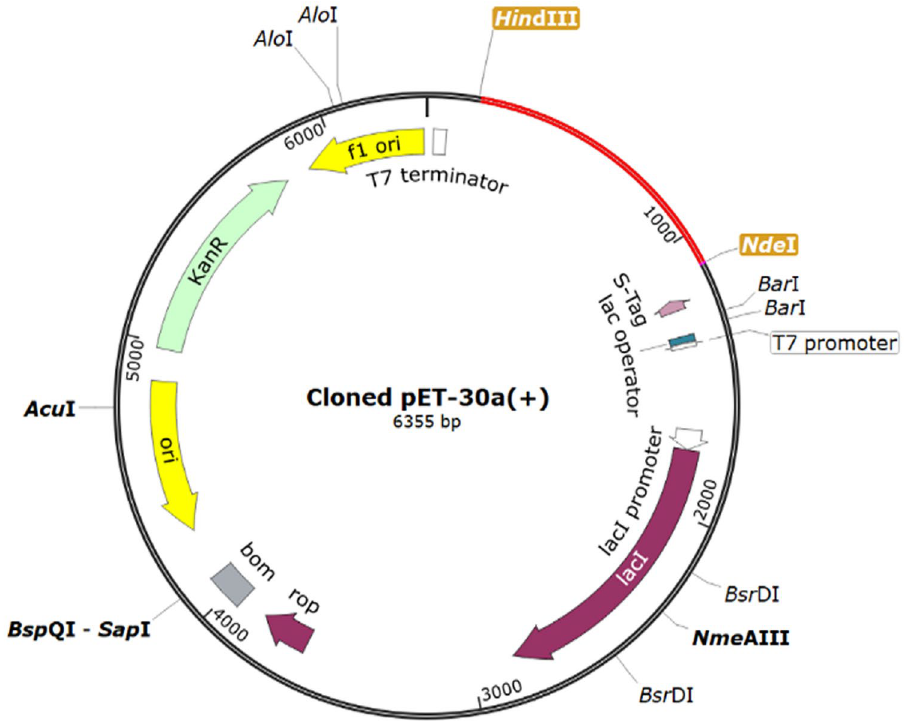
Figure 7. Expression vector pET30a (+). In silico restriction cloning of the multi-epitope vaccine sequence into the pET30a (+) expression vector using SnapGene software free-trial (https ://www.snapg ene.com/free-trial /), the red part represents the vaccine’s gene coding, and the black circle represents the vector